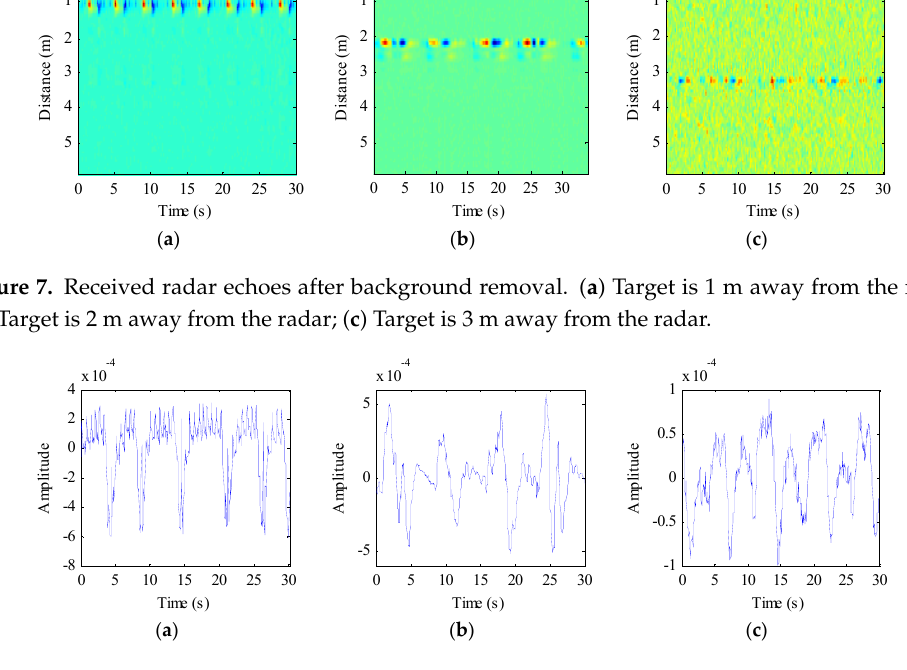
Figure 8. The waveform of target vital signs. ( a ) Target is 1 m away from the radar; ( b ) Target is 2 m away from the radar; ( c ) Target is 3 m away from the